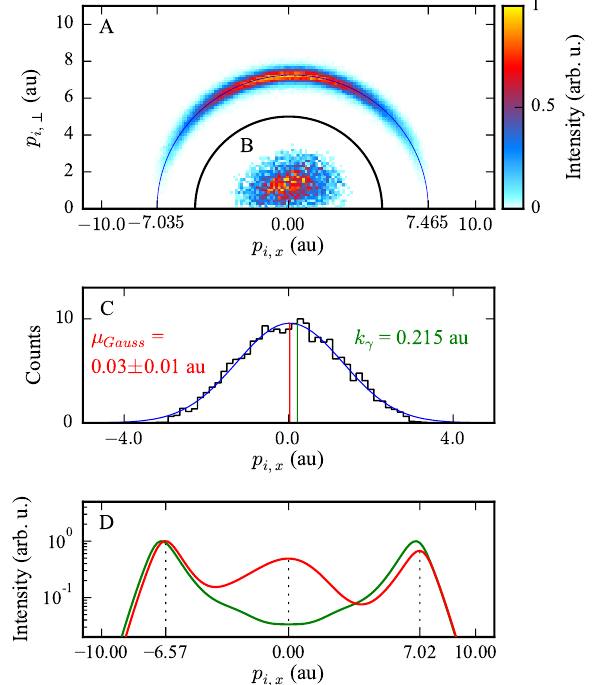
Figure 3. Photo-ion distributions of He double ionization by a single 800 eV photon. ( A ) The experimental data shown are limited to ε < 0.005 or ε > 0.995 and correspond to double ionization through the shake-off process. The blue semicircle is shifted to the right by the photon momentum. The SO photo-ions accumulate on this semicircle. ( B ) The experimental data shown are limited to 0.35 < ε < 0.65 and ϑ 12 > 160 ◦ . They resemble double ionization via QFM. ( C ) Projection of data from B onto the x axis (black) and Gaussian fit (blue) to obtain the center of the momentum distribution of QFM photo-ions along the light propagation direction (red, µ Gauss ). Note that the indicated error is the standard deviation of the mean value from the Gaussian fit estimated as the square root of the respective diagonal element of the covariance matrix. The green line indicates the photon momentum for comparison. ( D ) Dipole (green) and nondipole (red) TDSE calculations for helium double ionization with 800 eV linearly polarized photons. The polarization vector is parallel p single p single to the z axis and the data shown are limited to p i , y = 0 ± & p i , z = 0 ± . Experiment and 2 4 theory suggest that the photon momentum is not imprinted onto QFM